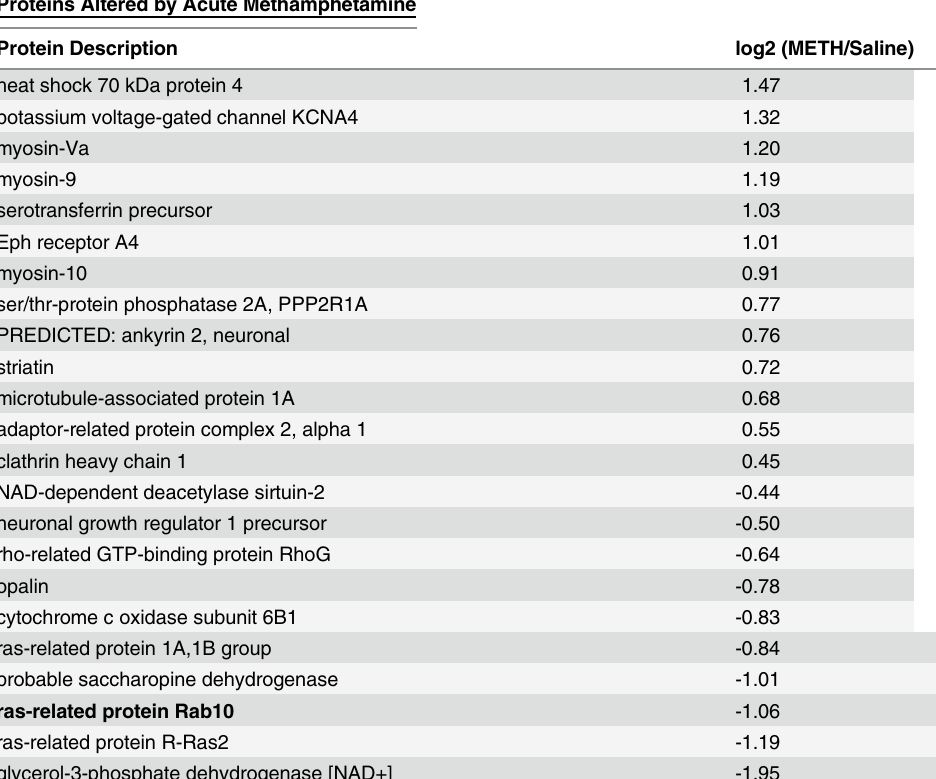
Table 1. Proteins whose abundance in striatal raft fractions was altered by treatment with methamphetamine. Proteins Altered by Acute Methamphetamine Protein